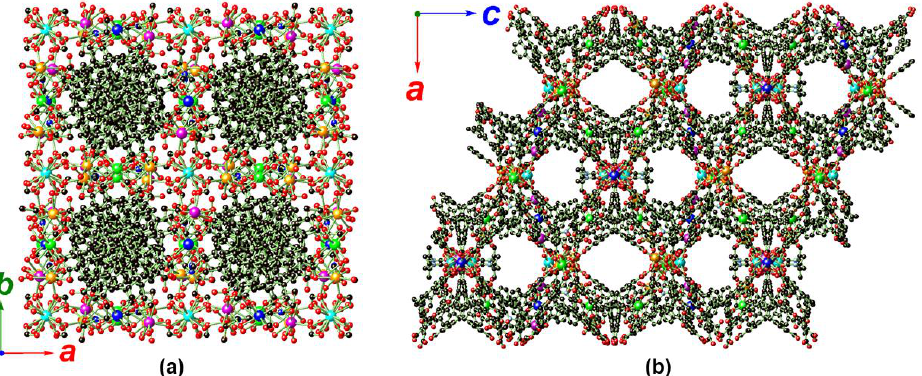
Figure 4. Crystal packing diagrams of MOF 1 looking along the crystallographic c direction, showing the densely packed BTB ligands ( a ), and along the crystallographic b direction, showing the channels with rhombohedral apertures ( b ). All disordered components, dissociated DEF solvate, and hydrogen atoms are omitted for clarity. Color legend: C: black, N: light blue, O: red, Cd1 / Cd2: orange, Cd3: magenta, Ca1: green, Ca2: cyan, Ca3: blue.